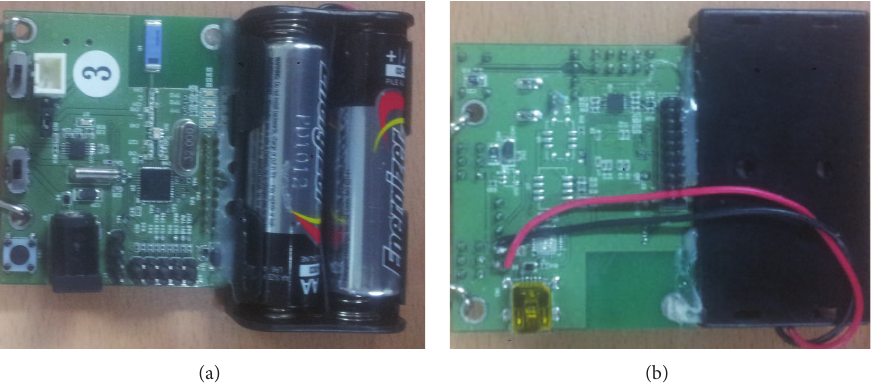
Figure 1: Photograph of the sensor node (80 mm × 50mm) for fall detection. (a) Front side and (b) back